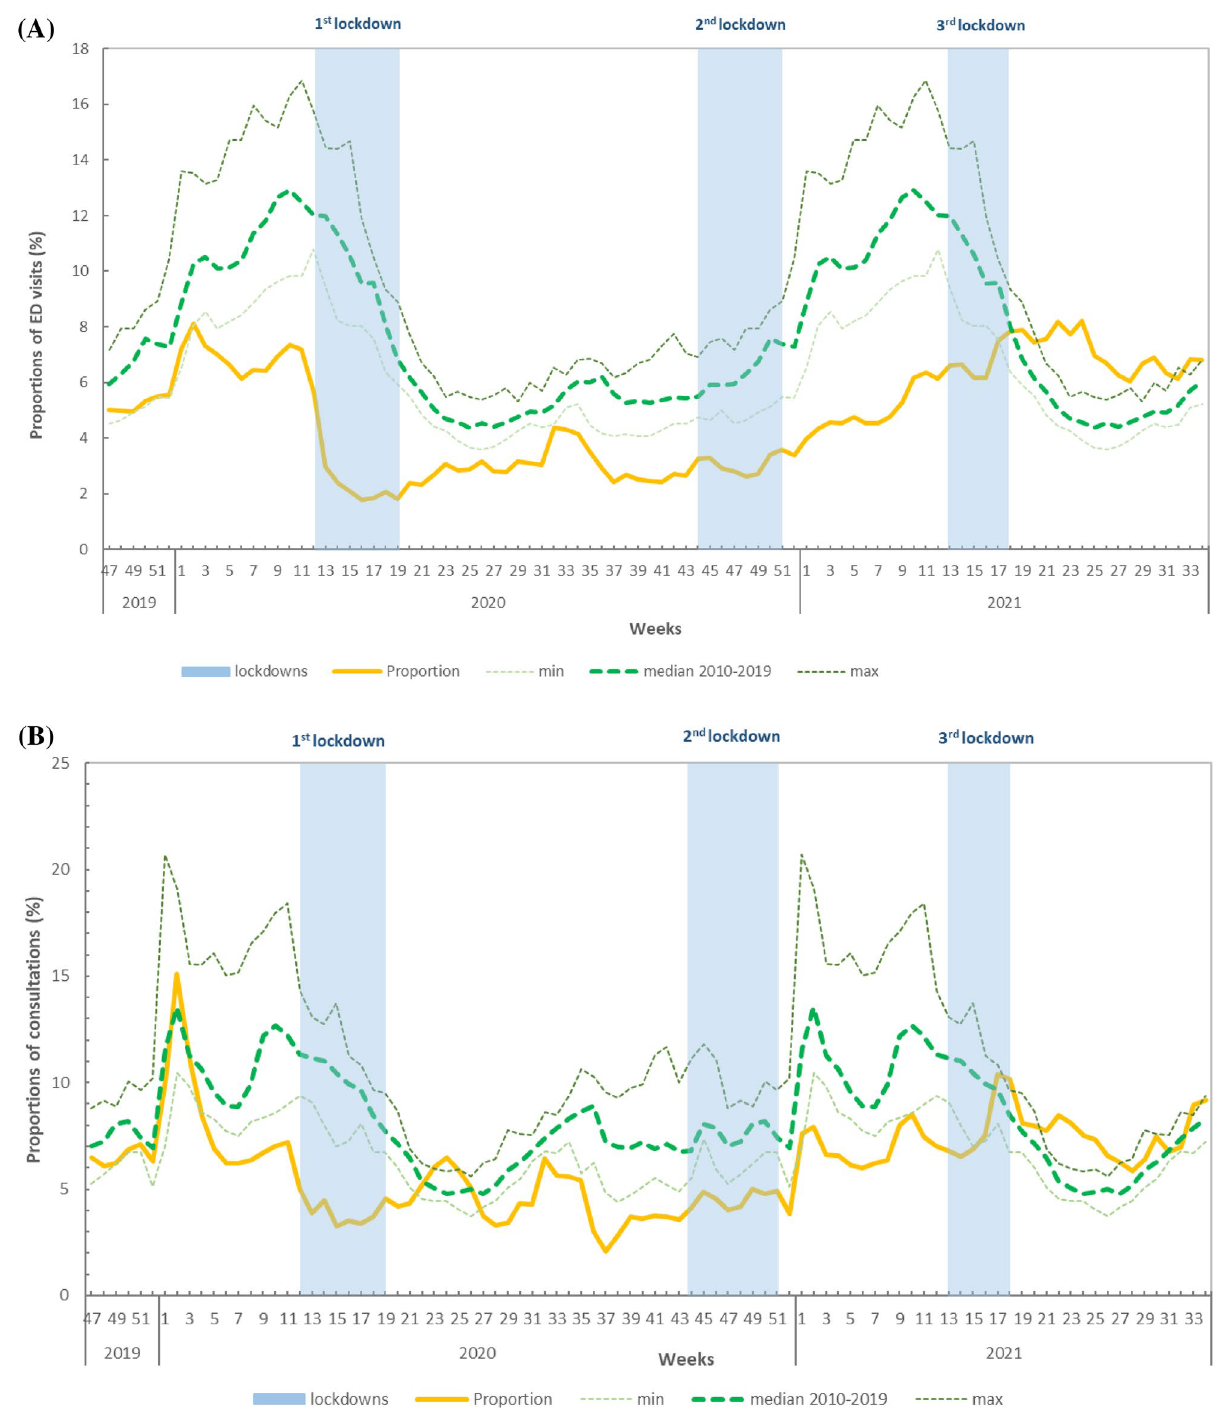
Figure 2. Weekly proportion of consultations for acute gastroenteritis, November 2019–August 2021 (yellow line), in ( A ) emergency departments (OSCOUR), ( B ) GP-emergency house-calls (SOS Médecins), and minimum, median and maximum of these indicators in 2010–2019 (dotted lines), children under 5 years old, France. Light blue boxes: nationwide